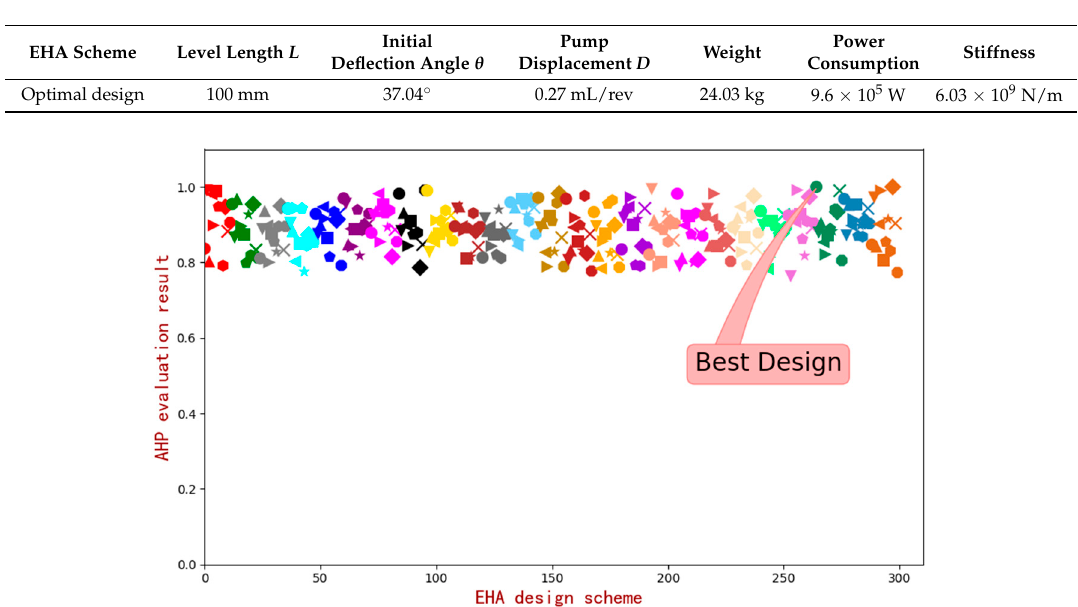
Table 3. The corresponding design parameters and objectives values of EHA optimal design.